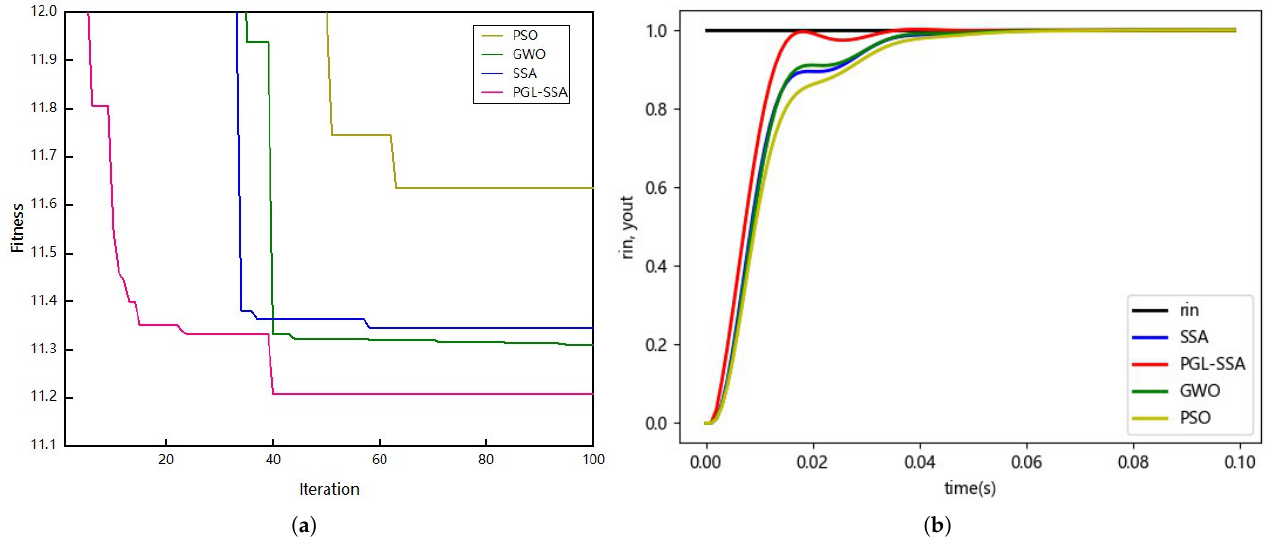
Figure 12. Convergence curves and step response curves of different algorithms for PMSM systems. ( a ) Convergence curve. ( b ) Step response